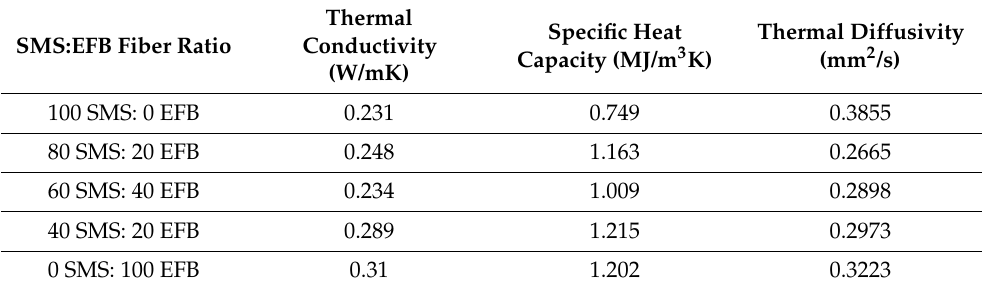
Table 2. Thermal conductivity, specific heat capacity, and thermal diffusivity of the sandwich composite panel at different SMS and EFB fibers